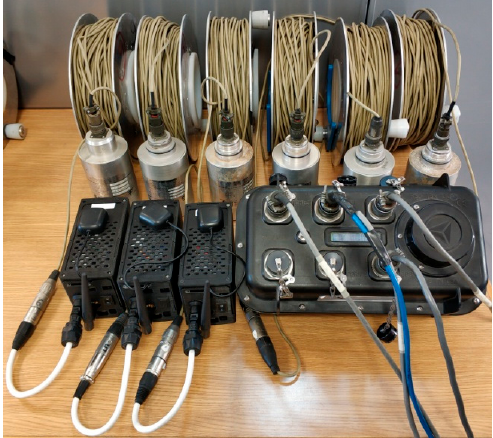
Figure 16. Mark L-4 sensors connected to the commercial equipment, Reftek, and the developed acquisition system, Geophonino-W.